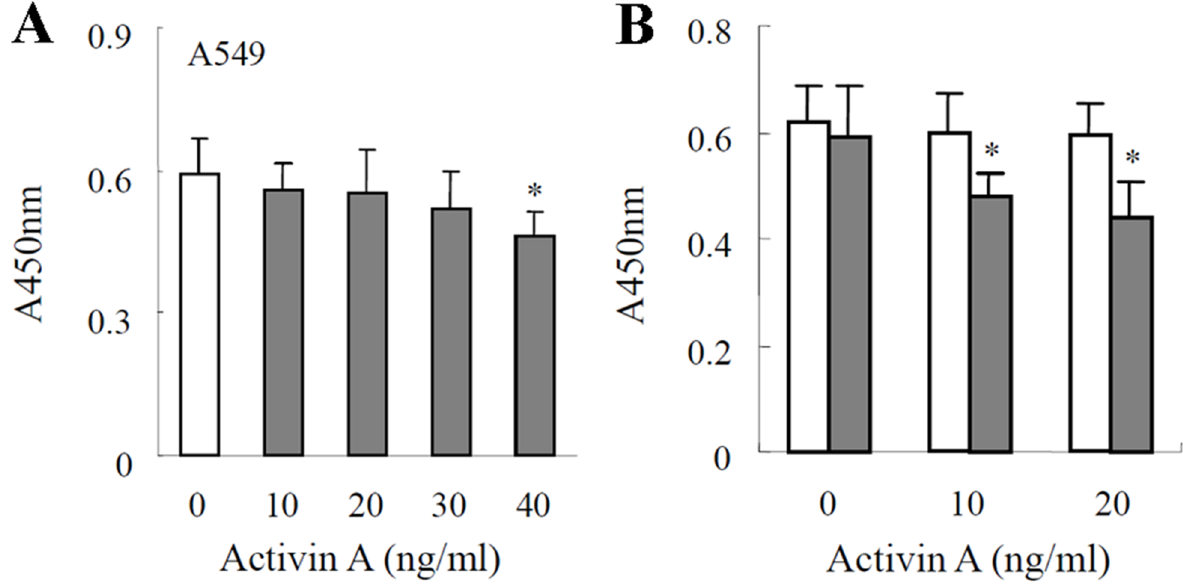
Figure 4. The effect of anti-FST antibody on proliferation of lung adenocarcinoma cells. (A) Proliferation of lung adenocarcinoma A549 cells treated with 0–40 ng/ml activin A for 24 h was determined by using the cell counting kit-8. Absorbance was detected at 450 nm to express the cell viabilities. * P , 0.05 compared with 0 controls. (B) A549 cells were incubated in the presence of 0–20 ng/ml activin A ( % ) or 1 m g/ml anti-FST monoclonal antibody + 0–20 ng/ml activin A ( & ).* P , 0.05, compared with activin A group and 0 control.